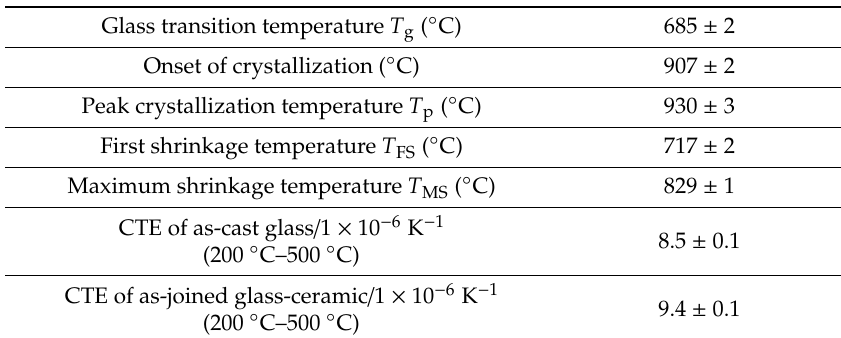
Table 2. Characteristic temperatures and coe ffi cient of thermal expansion (CTE) of HJ28 glass system, obtained from DTA, HSM, and